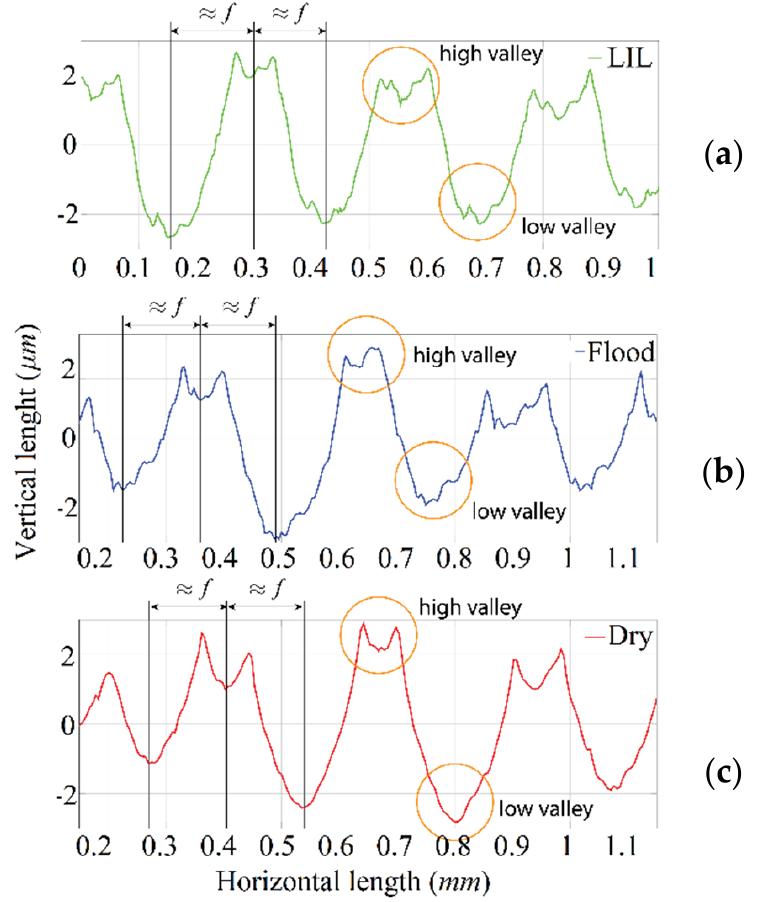
Figure 15. Roughness profiles for 0.25 mm depth of cut and 0.15 mm/rev of feed rate; ( a ) Turning under LIL condition; ( b ) Turning under flood lubrication; ( c ) Turning in dry condition.